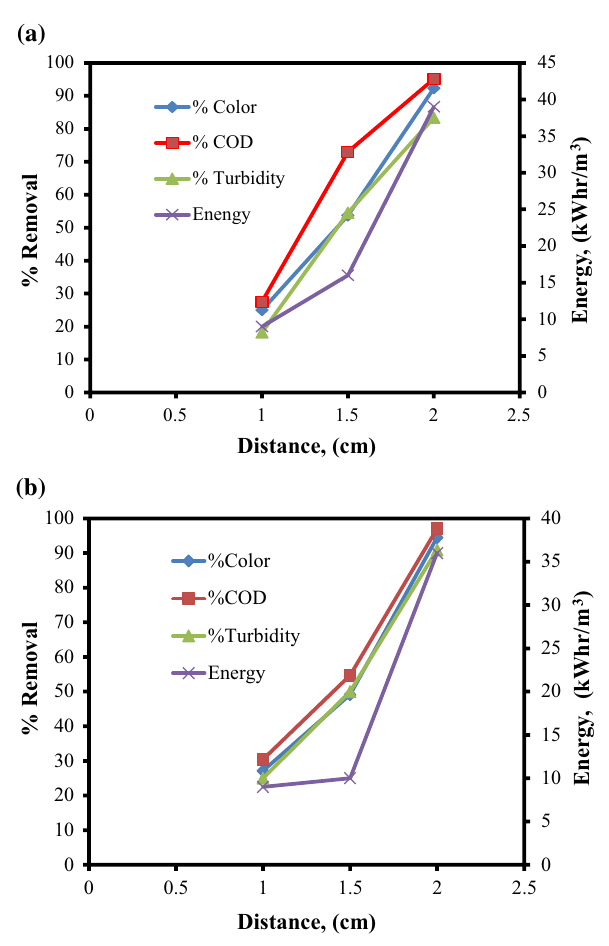
Fig. 6 Removal efficiency and power consumption versus distance between electrodes on a Al and b